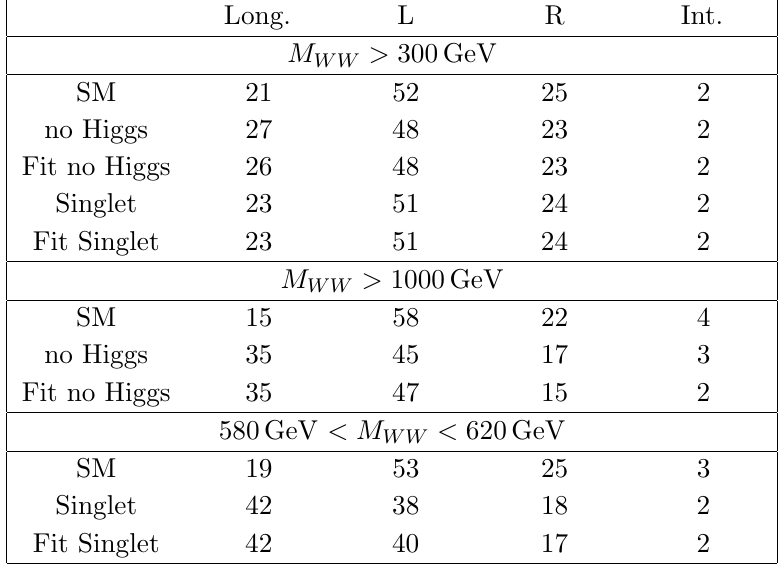
Table 1. The rows labeled SM, no Higgs and Singlet show the percent ratio of the polarized cross sections to the full result. The rows labeled Fit give the coe(cid:14)cients, in percent, extracted from a (cid:31) 2 (cid:12)t of a linear combination of the SM shapes for the longitudinal, left, right handed components and the interference to the full unpolarized angular distribution in the corresponding